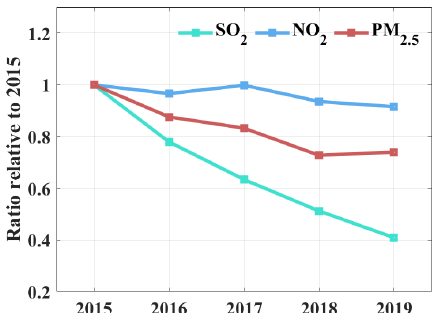
Figure 4. Interannual variations in the ratios of observed annual mean concentrations of SO 2 , NO 2 and PM 2 . 5 relative to those in 2015 averaged over the